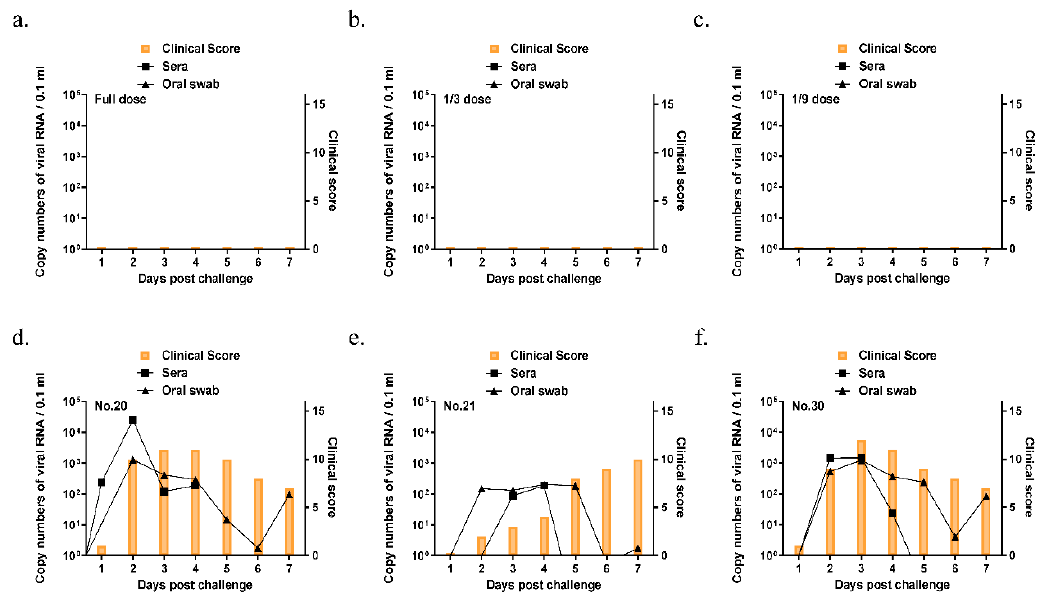
Figure 7. Clinical scores and virus shedding in pigs immunized with a bivalent vaccine after the A/Yeoncheon/SKR/2017 challenge. Oral swab and blood samples were collected daily from the pigs ( n = 18) that were vaccinated with the bivalent vaccine in the full dose ( a ), 1/3 dose ( b ), 1/9 dose ( c ), and control ( d – f ) groups until 7 days post-challenge. Clinical symptoms were examined daily after the virus challenge. The foot-and-mouth disease virus (FMDV) RNA was identified by the extraction of viral RNA from oral swab samples and quantitative real-time polymerase chain reaction (RT-PCR).